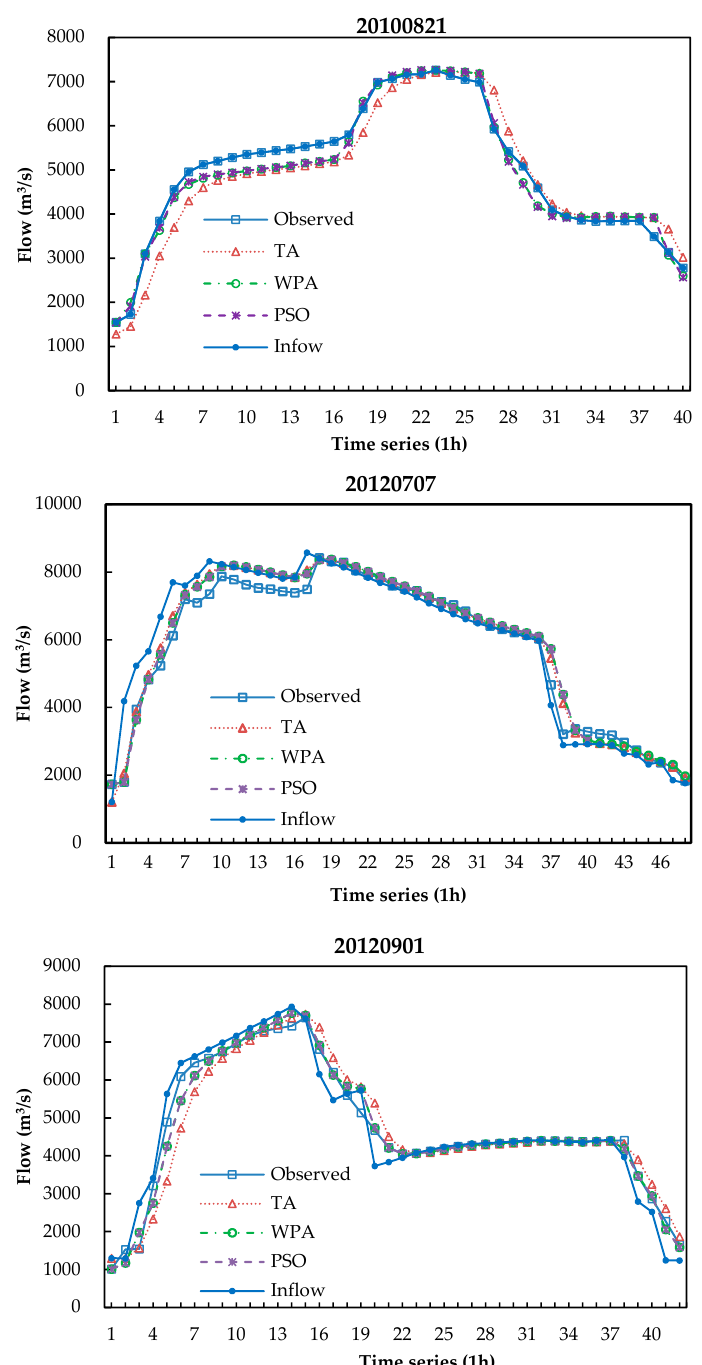
Figure 3. Simulation results of different floods in Reach 1.